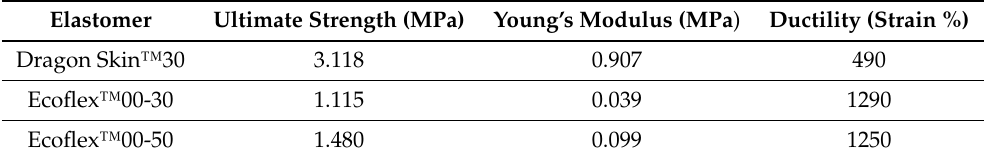
Figure 3. Stress–strain curve of the three materials. Table 1. The mechanical properties of the measured elastomer